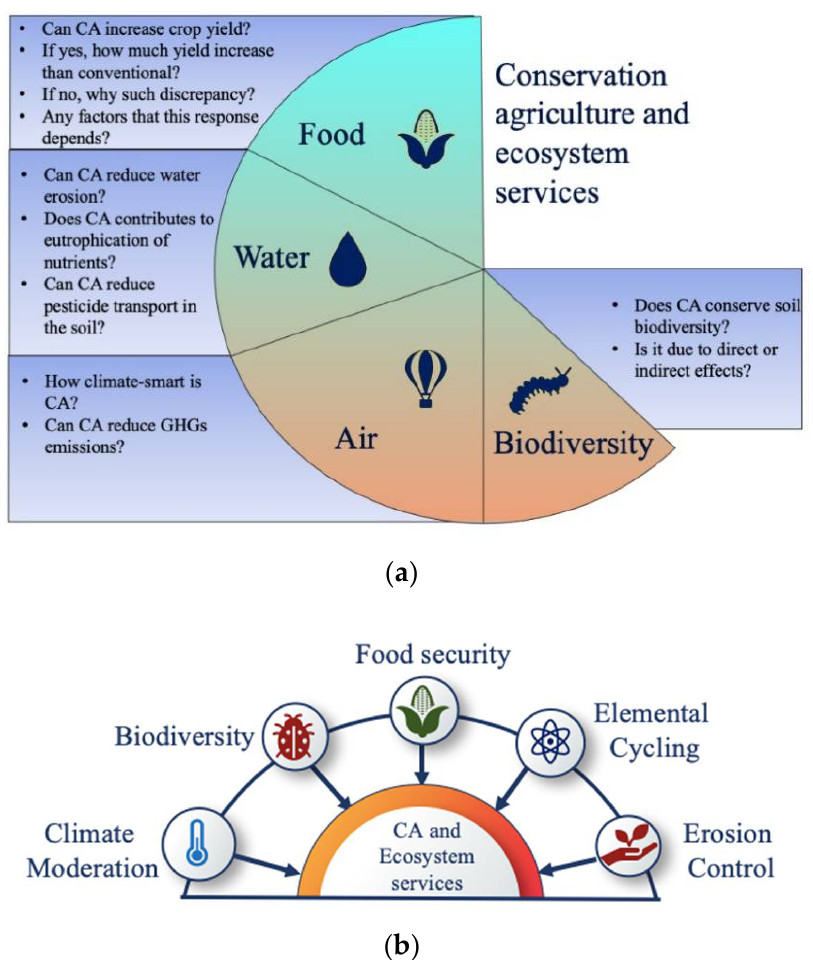
Figure 1. ( a ) Ecosystem services offered through conservation agriculture (top); and ( b ) a schematic diagram depicting the main ecosystem services delivered through conservation agriculture (Source: Modified from [12]).